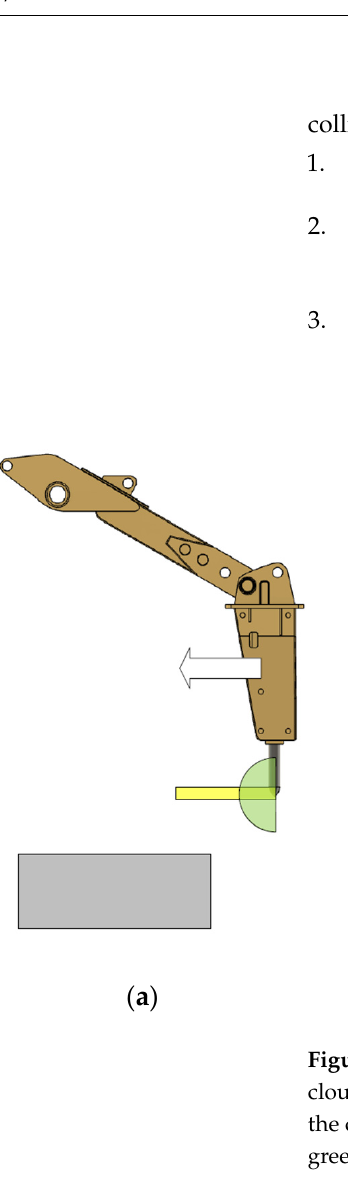
safety of executing a